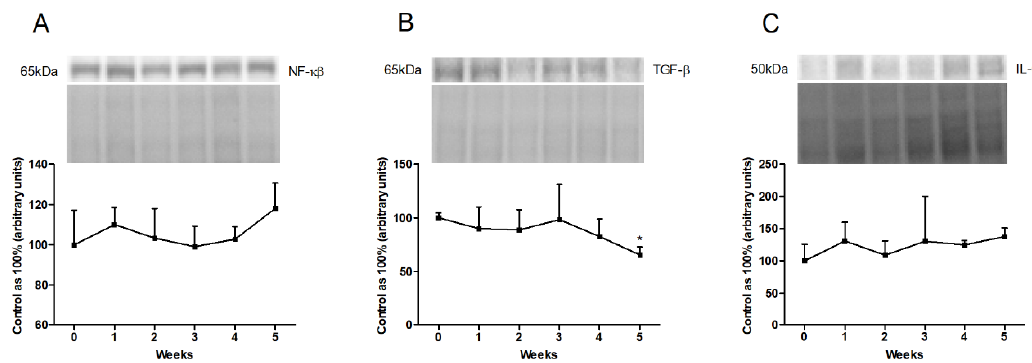
Figure 5. Representative Western blots illustrating the expression of inflammatory pathway proteins, i.e., ( A ) nuclear factor-κβ (NF-κβ), ( B ) transforming growth factor β (TGF-β) and ( C ) interleukin-6 (IL-